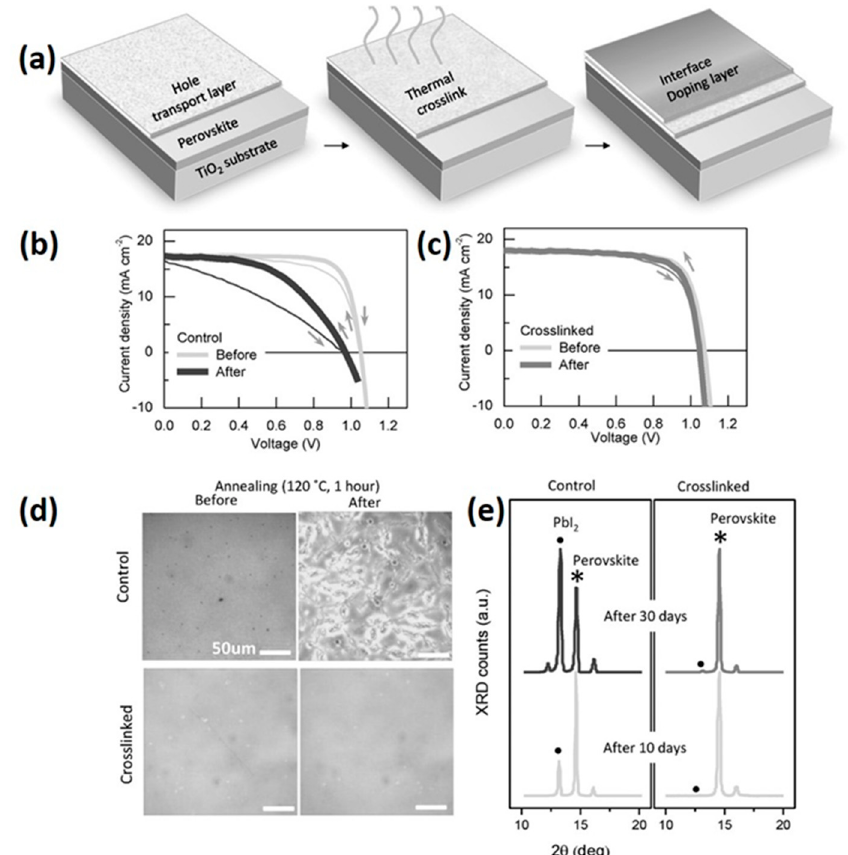
Figure 8. ( a ) Two-step process to form an insoluble and thermally stable hole extraction contact. ( b ) The performance of devices using Spiro-OMeTAD as the hole extraction contact tested at room temperature (light gray) and after annealing at 110 °C (dark gray). ( c ) The performance of devices using VNBP-MoO 3 tested at room temperature (light gray) and after annealing at 110 °C (dark gray). ( d ) Optical microscopy images of doped Spiro-OMeTAD and VNBP-MoO 3 films before and after annealing. ( e ) XRD patterns illustrating the evolution of perovskite content in the device active layer. Reprinted from [63], with permission.